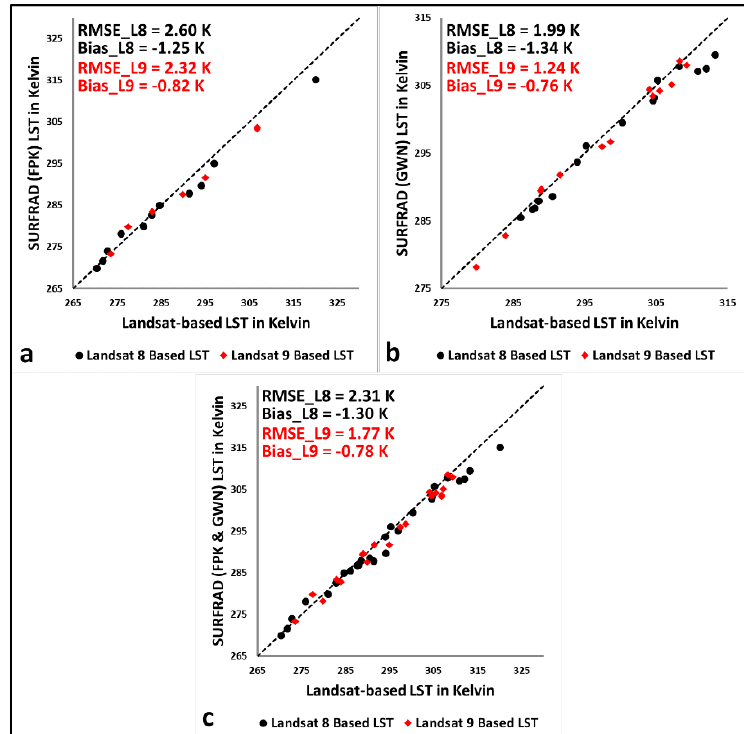
Figure 5. Validations and comparative analysis between Landsat-based LST and SURFRAD-based LST; a) LST results from FPK station, (b) LST results from GWN station, (c) Total LST results from FPK and GWN